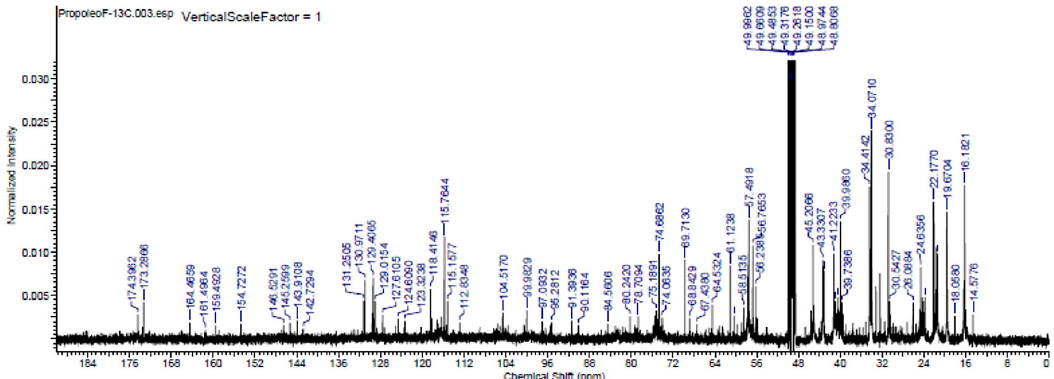
Figure 5. Carbon-13 nuclear magnetic resonance spectrum (125 MHz, CD 3 OD, ppm ) of the methanolic fraction of Oxapampa propolis.